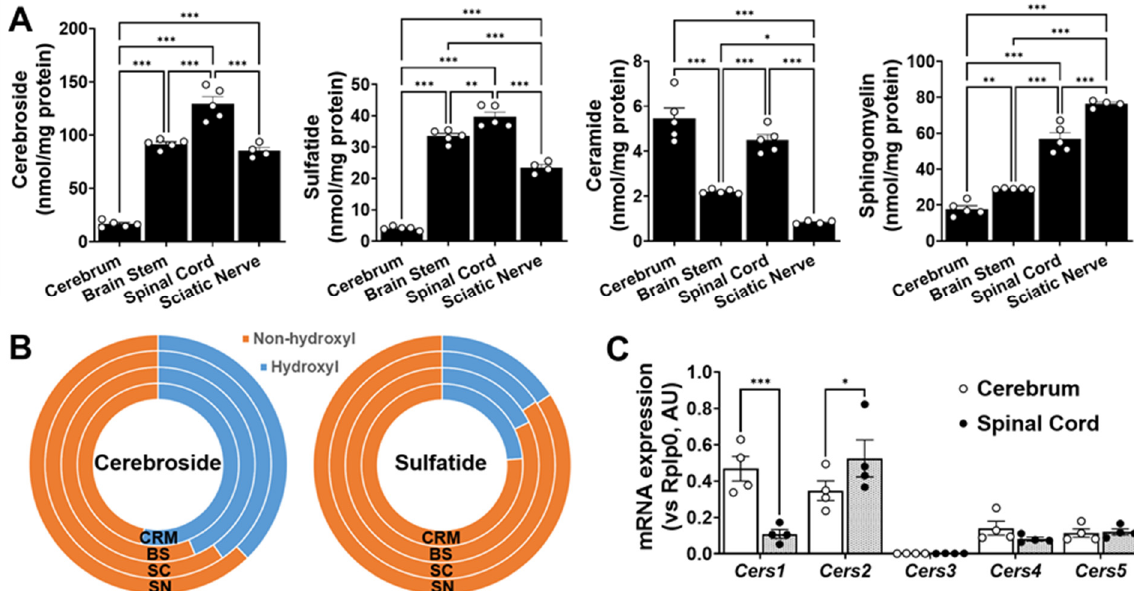
Figure 5. Nervous tissues analyzed display different sphingolipid mass and sphingolipid biosynthesis-related gene expression levels. Total amounts of Cer, SM, cerebroside, and sulfatide in cerebrum (CRM), brain stem (BS), spinal cord (SC), and sciatic nerve (SN). Total mass levels of individual lipid classes were compared between nervous tissues using ordinary one-way (non-paired) ANOVAs followed by Tukey’s multiple comparisons tests ( A ). Comparison of hydroxyl vs. non-hydroxyl molecular species for cerebroside and sulfatide ( B ). Gene expression levels of each ceramide synthase in cerebrum and spinal cord ( C ). Gene expression levels were compared between nervous tissues using two-way (non-paired) ANOVAs, followed by Tukey’s multiple comparisons tests (GraphPad Prism 9 software). Adjusted p -value <0.05 (*), <0.01 (**), and <0.001 (***) for all statistical comparisons.